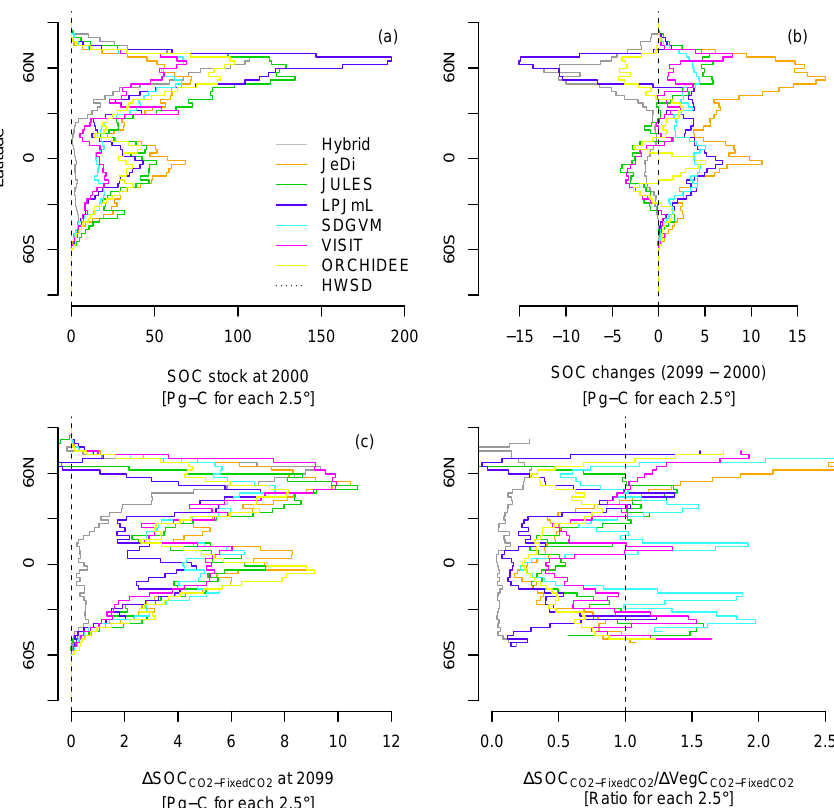
Fig. 5. Latitudinal SOC stocks (a) , SOC changes (2099–2000 in RCP8.5) (b) , and indirect CO 2 effect on SOC (CO 2 experiment–fixed CO 2 experiment at 2099 in RCP8.5) (c) in HadGEM. In (a) , the line of HWSD (broken black line) indicates the data from harmonized soil database (Hiederer and Köchy, 2011)